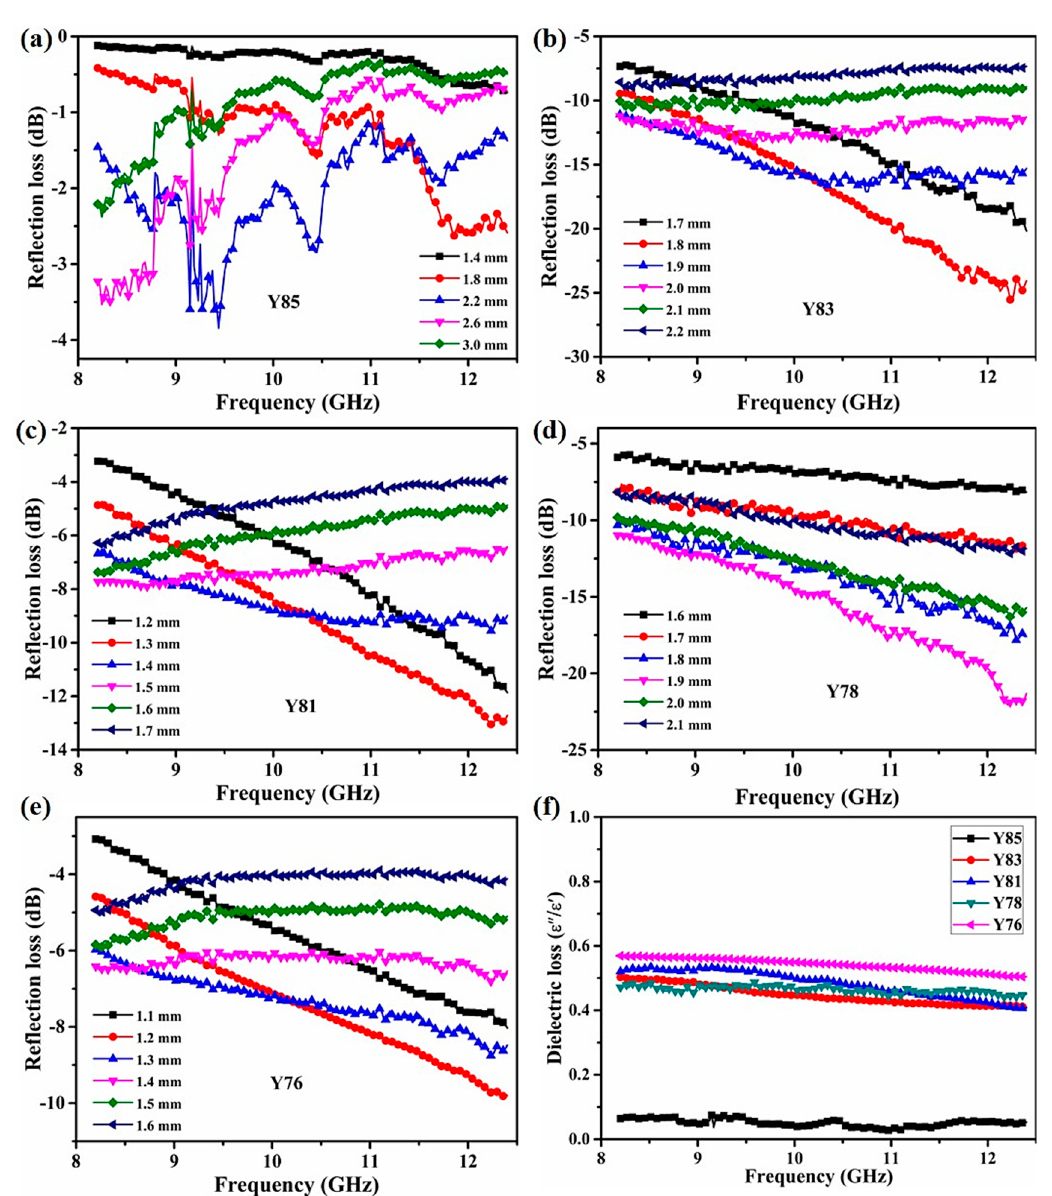
Figure 4. ( a – e ) Reflection loss with different absorber thicknesses and ( f ) dielectric loss curves of the plasma-sprayed Y 2 O 3 /ZrB 2 /CNT hybrids.